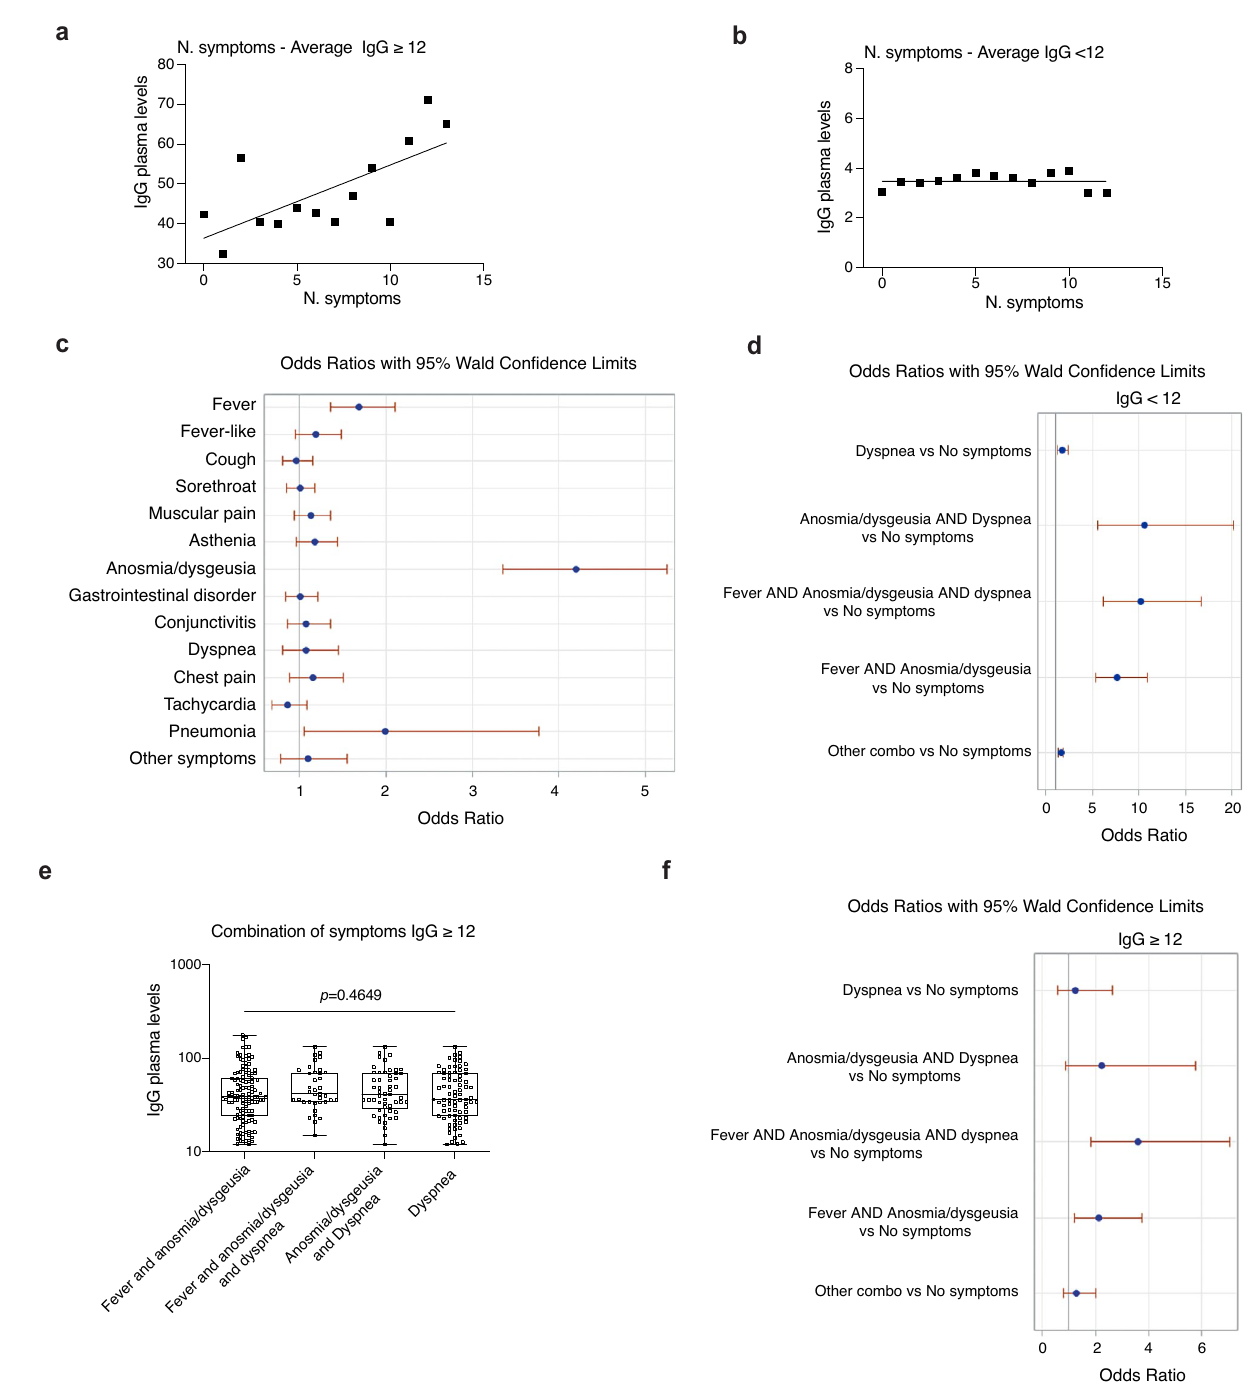
Figure 5. Distribution of IgG plasma levels in relation to symptoms. ( a ) Distribution of IgG plasma levels versus the number of self-reported symptoms in IgG positive individuals (IgG ≥ 12 AU/mL). ( b ) Distribution of IgG plasma levels versus the number of self-reported symptoms in IgG negative individuals (IgG < 12 AU/ mL). ( c ) Association between symptoms and IgG plasma levels. p < 0.0001, LR test for global null hypothesis. Odds ratio (OR) calculated with logistic regression for ordinal data. ( d ) Analysis of plasma levels of the whole population in relation to a combination of symptoms, p < 0.0001. Odds ratio (OR) calculated with logistic analysis for ordinal data. ( e ) Distribution of IgG plasma levels versus selected symptoms (alone or in combination) in individuals with IgG ≥ 12 AU/mL. p -values evaluated using Kruskal–Wallis test with Dunn’s post-hoc test. ( f ) Analysis of plasma levels of positive subjects (IgG ≥ 12) in relation to a combination of symptoms, p = 0.0004. Odds ratio (OR) calculated with logistic analysis for ordinal